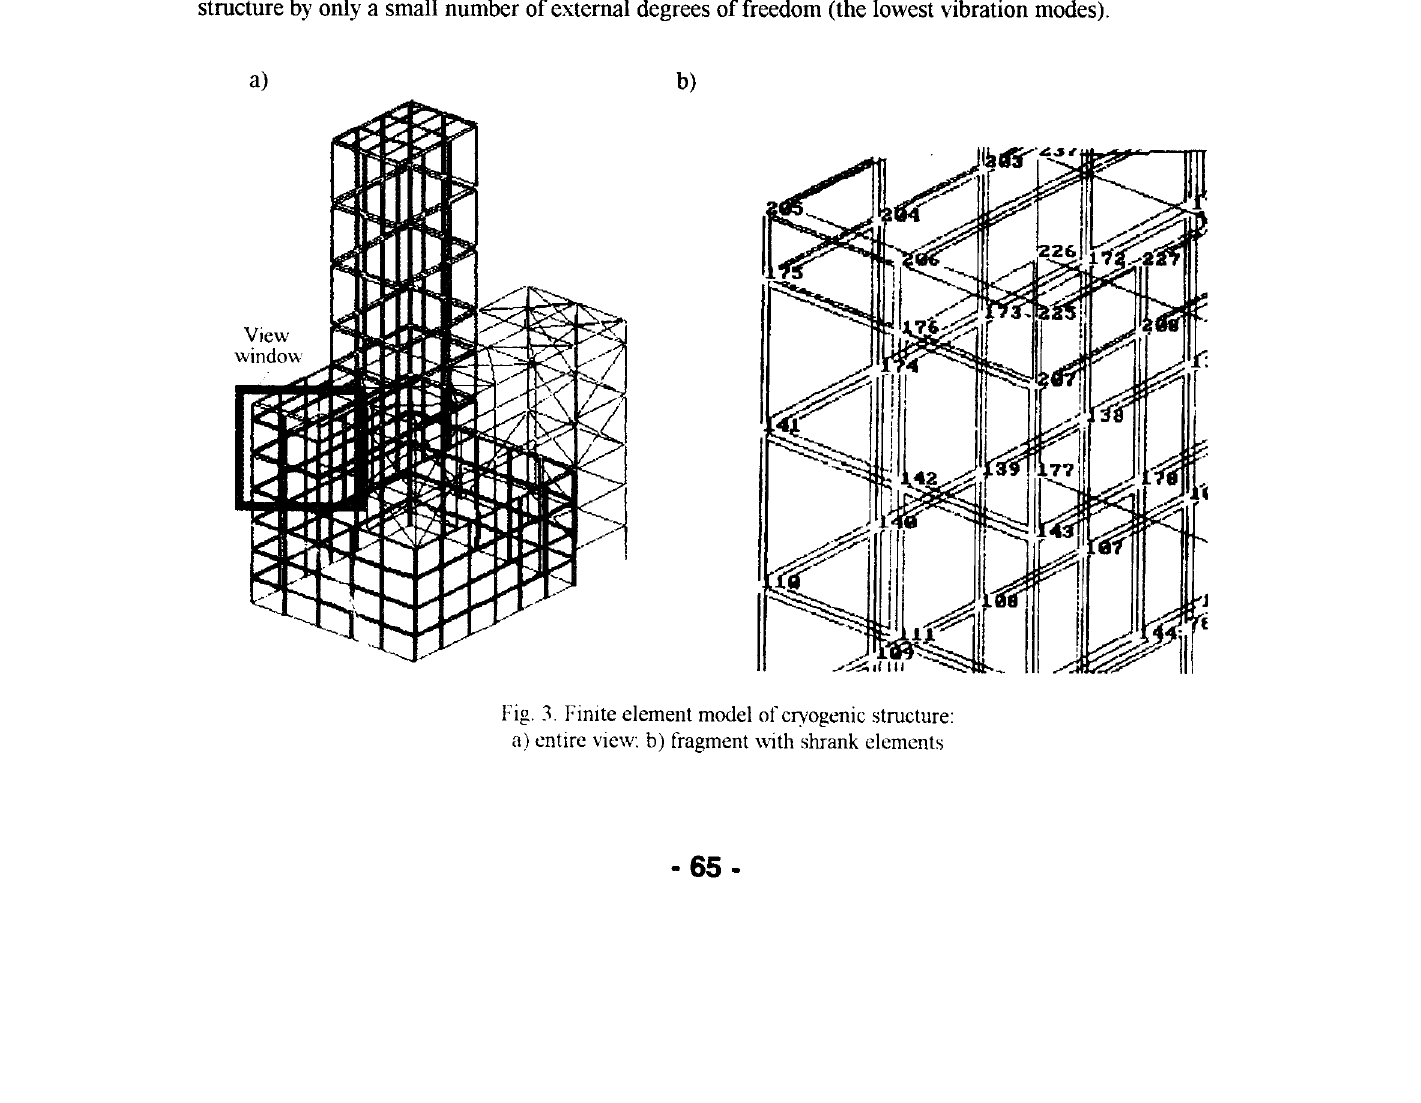
Fig. 3. Finite element model of cryogenic